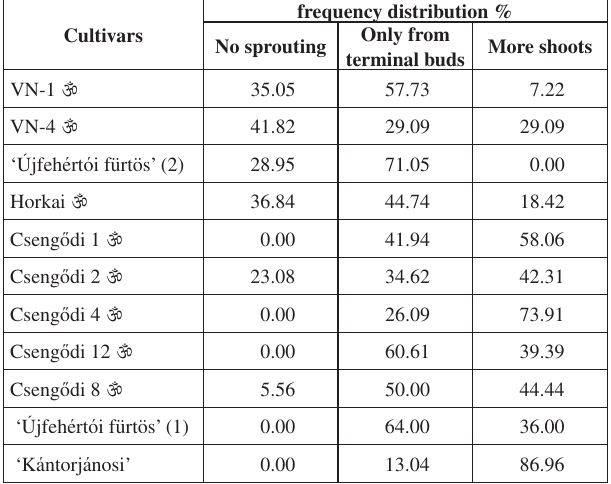
Table 4: The frequency distribution of shoots on 2-year-old canopy parts of sour cherries depending on growth characteristics (Pallag and Újfehértó,